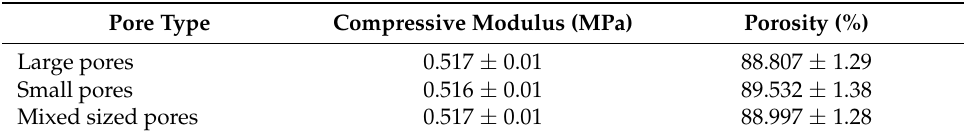
Table 1. Compressive modulus and porosity of PLGA scaffolds with different pore sizes. Values represent mean ± SD ( n = six per group for compressive modulus; n = five per group for porosity